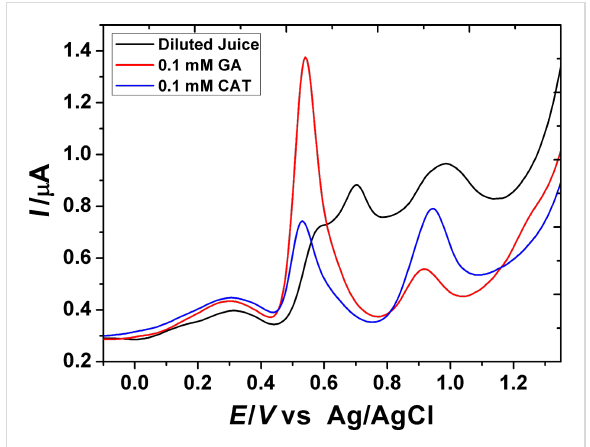
Figure 7: SW voltammograms of a pomegranate juice sample (black), 0.1 mM GA (red) and 0.1 mM CAT (blue) in 0.2 M H 3 PO 4 (pH 2.0) on the PGA/MWCNT/GC modified electrode.